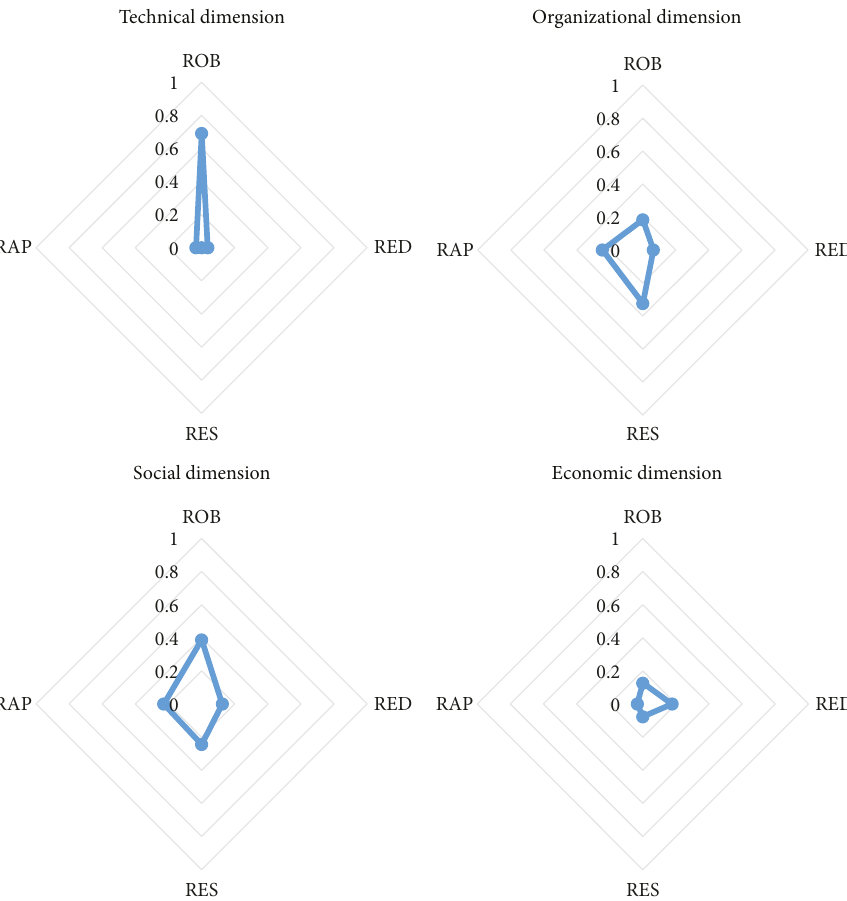
Figure 3: Spider graphs showing the values of speci fi c components of resilience according to the metrics de fi ned in Table 11. Table 12: Summary of the resilience assessment model in the L ’ Aquila case study, referring to scenarios (1) and (2).